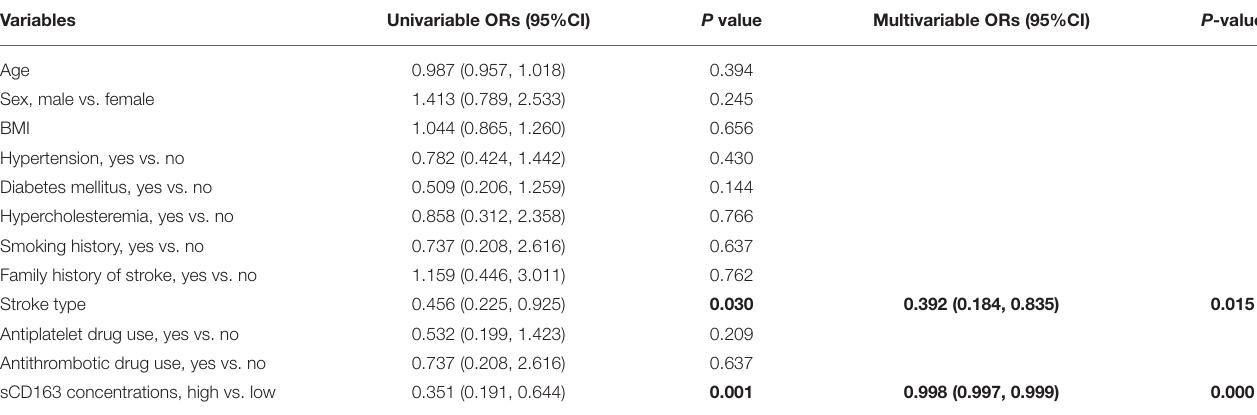
Dependent variable: Poor outcome as indicated by mRS = 4 or 5 at follow-up. Factors that are potentially associated with sCD163 levels were excluded from the model. Bold values represents statistically significant.